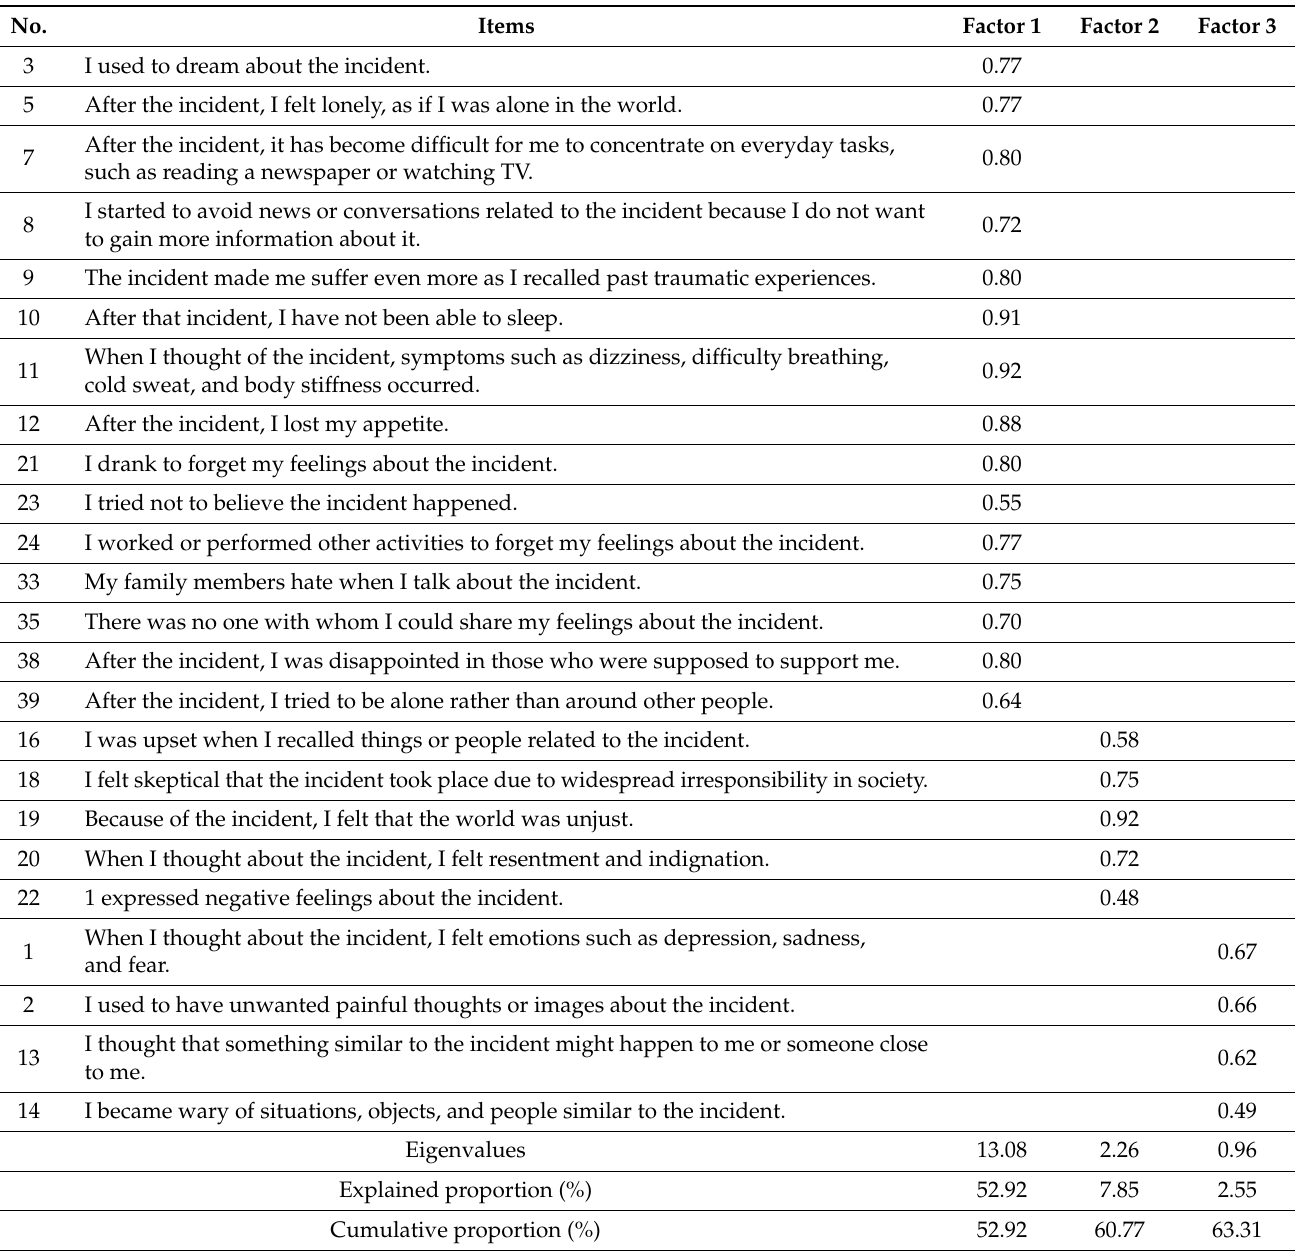
Table 2. The results of final exploratory factor